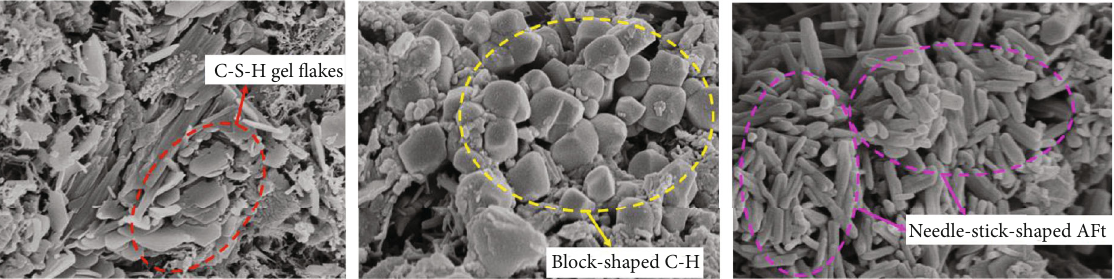
Figure 8: SEM pattern of 16-hour